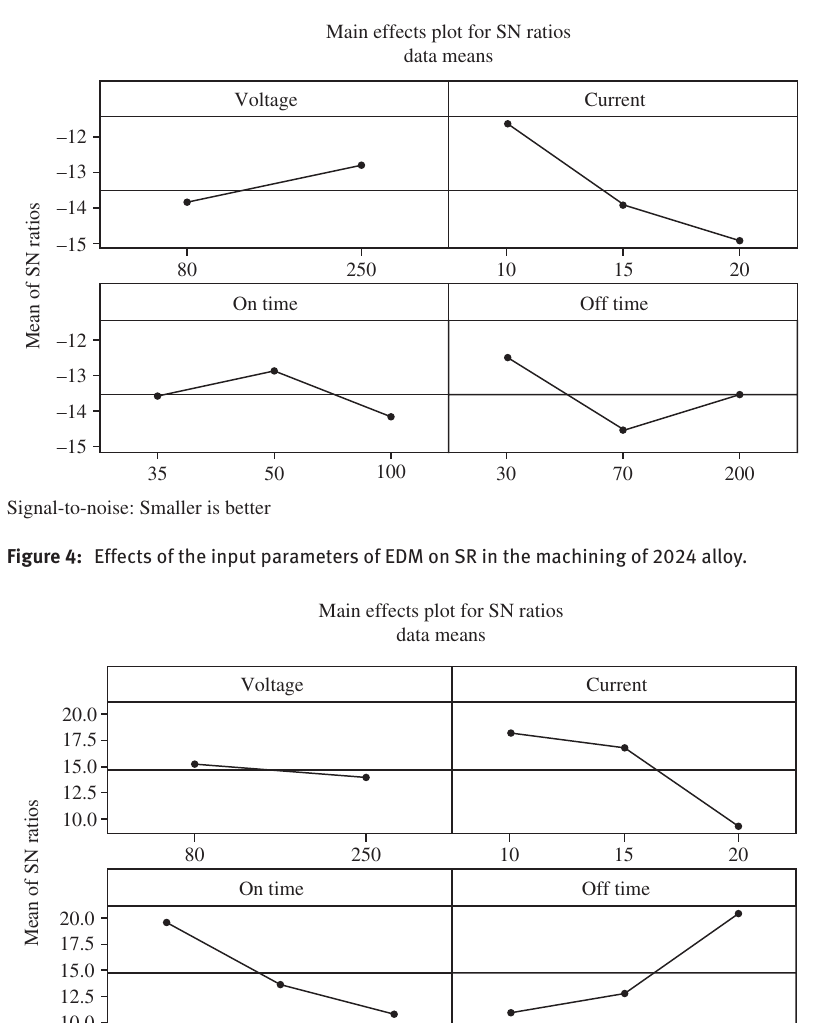
Figure 5: Effects of the input parameters of EDM on TWR in the machining of Al/5%Al